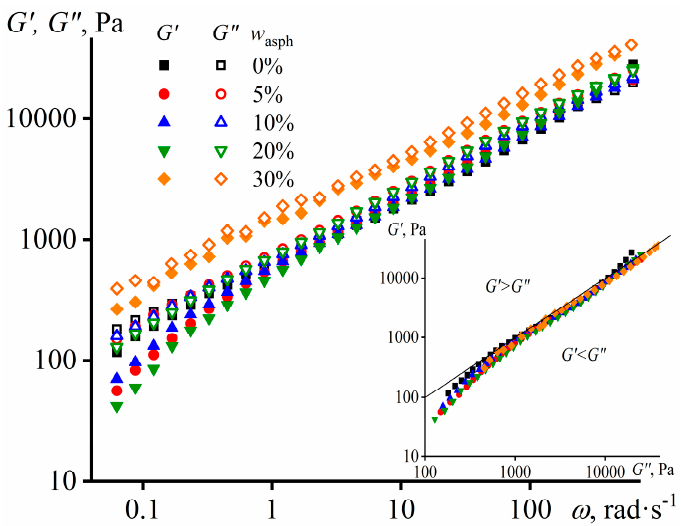
Figure 2. The frequency dependences of storage and loss moduli of PIB and its mixtures with different content of asphaltenes at 120 °C. The insert shows the same dependences but as Cole–Cole diagrams.